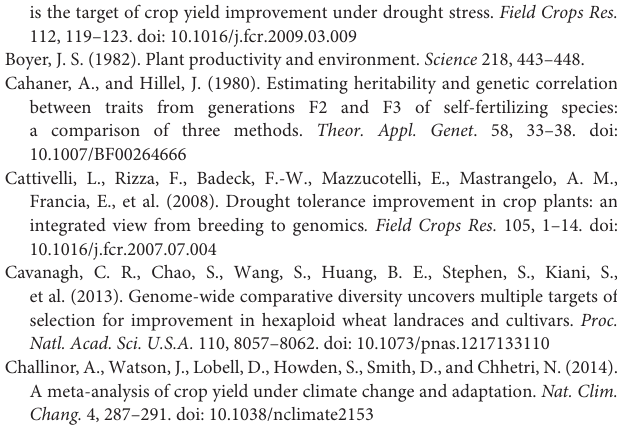
values. Table S4 | Spike per plant (Sp/P), grains per spike (G/Sp) and 1000 grain weight (TGW) under the well-watered (WW) and water-limited (WL) treatments in Year 1 and Year 2. Table S5 | Harvest index (HI), culm length (CL) and osmotic potential (OP) under the well-watered (WW) and water-limited (WL) treatments, and calculated osmotic adjustment (OA) in Year 1 and Year 2. Table S6 | Summary of published QTLs or genes for productivity and drought-related traits, mapped to chromosome 7AS in durum and bread wheat: GY, grain yield; Sp/P, spikes per plant; TGW, 1000 grain weight; DP–H, days from planting to heading; WW, well-watered; WL,